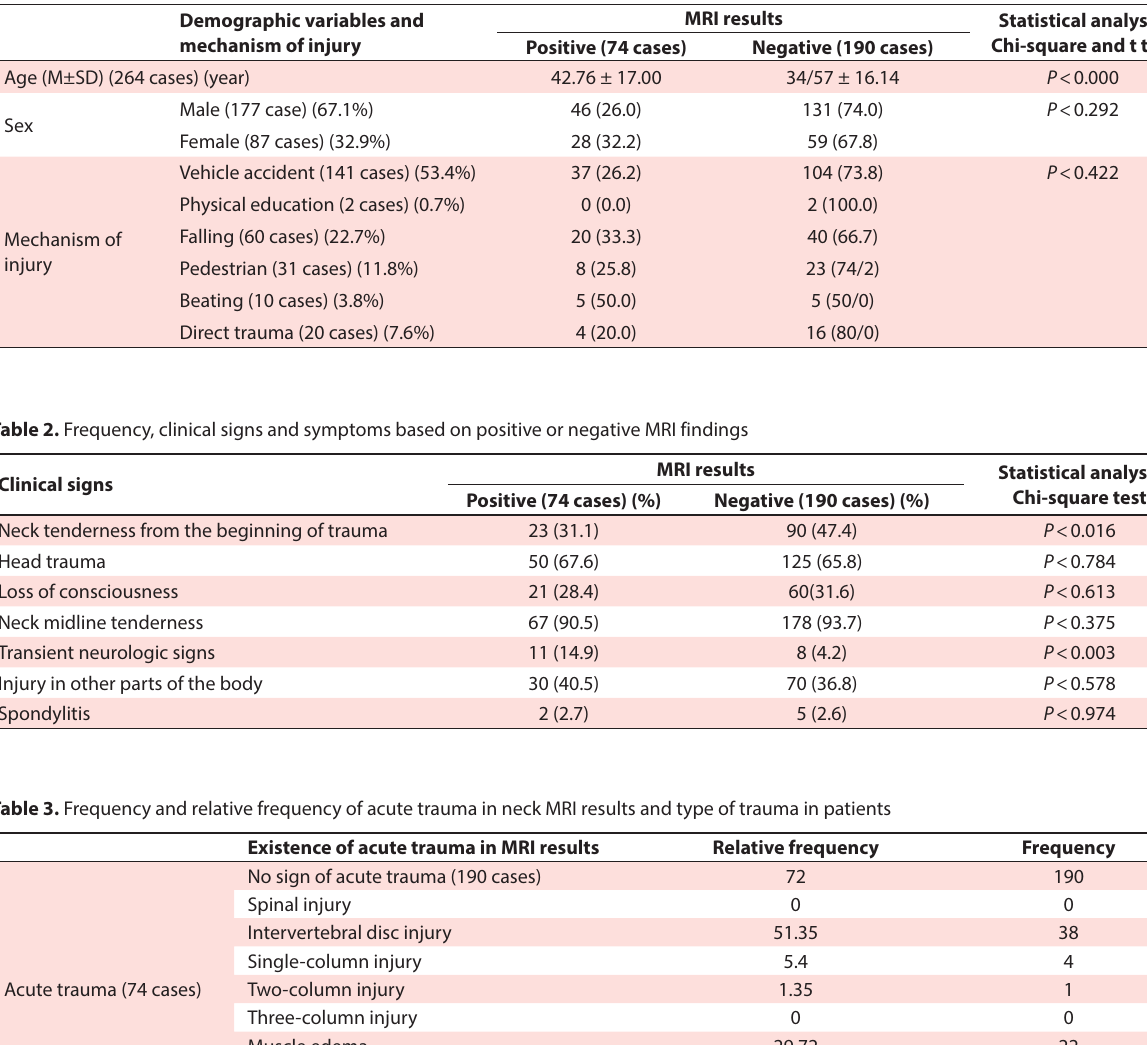
MRI results Statistical analysis: Chi-square and t testPositive (74 cases)